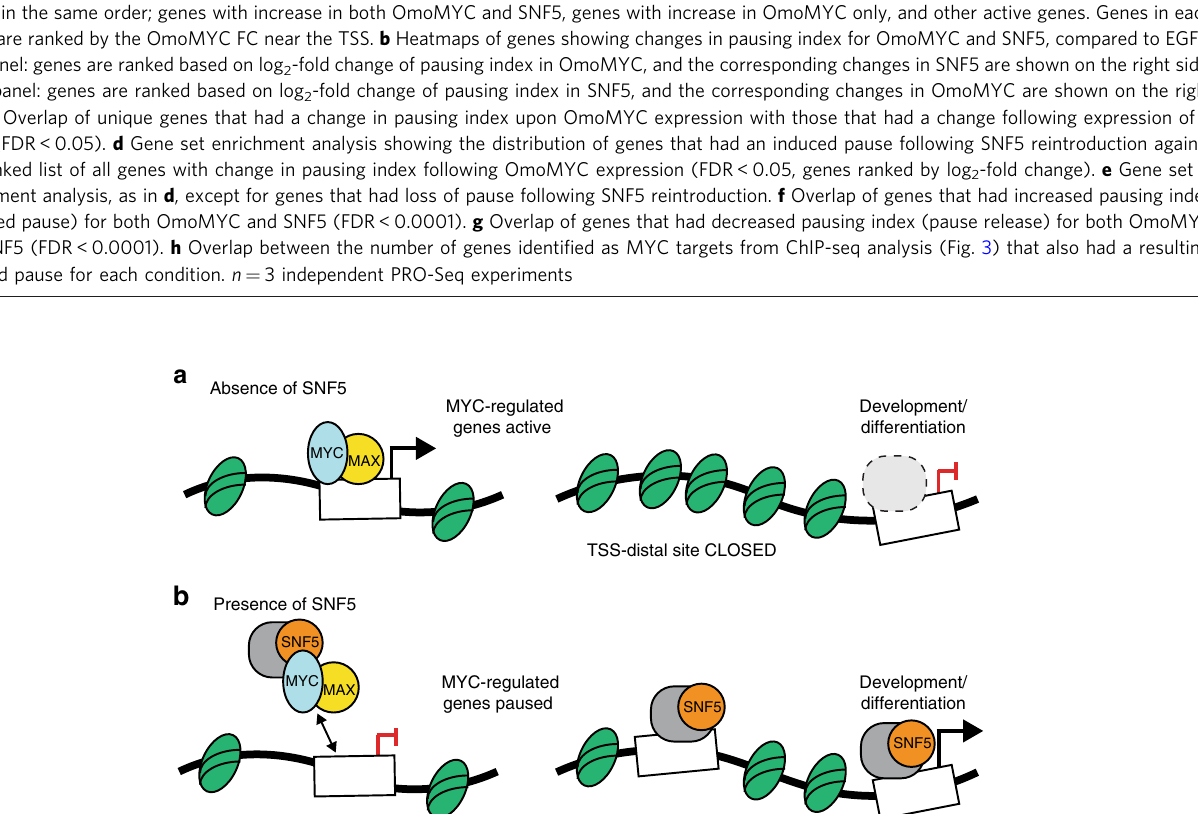
Fig. 5 Model: Dual tumor-suppressor activities of SNF5. a In the absence of SNF5, MYC binds unimpeded to chromatin to promote gene expression programs that maintain the MRT state. Under these conditions, transcription start site (TSS)-distal sites that regulate transcription of genes involved in development and differentiation remain in a closed state, repressing transcription. b When SNF5 is present, MYC binding to DNA is tempered and RNA polymerase pauses at these genes, repressing transcription. SNF5, in concert with the SWI/SNF complex (gray), also leads to remodeling at TSS-distal sites, resulting in an open chromatin state and activation of genes linked to development and